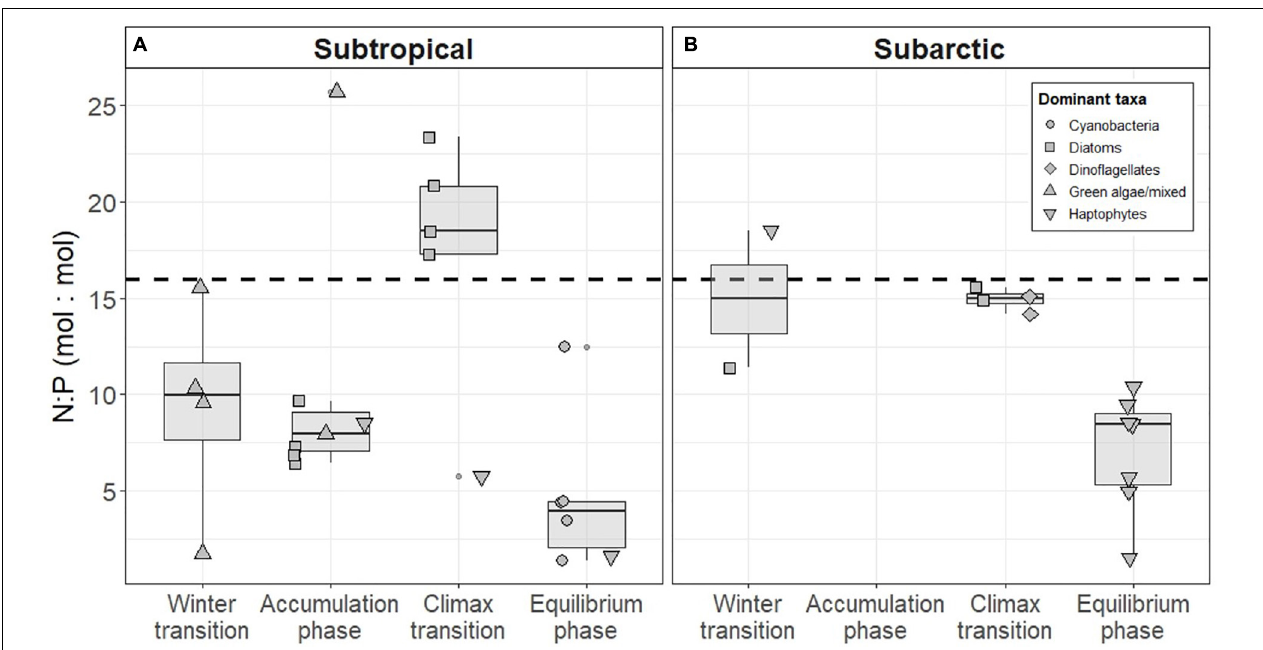
FIGURE 9 | Nitrogen (N) to phosphorus (P) ratios measured in the (A) subtropical and (B) subarctic western North Atlantic. The shape of each point indicates the dominant phytoplankton taxa estimated using a pigment-based community detection analysis. Boxes represent the median, first and third quartiles, whiskers are 1.5 interquartile range. Dashed line indicates the Redfield ratio of N:P